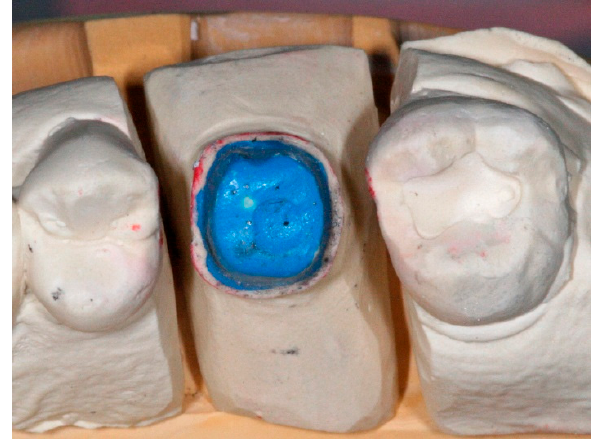
Figure 10. Conventional die for implant abutment supported crown fabrication.